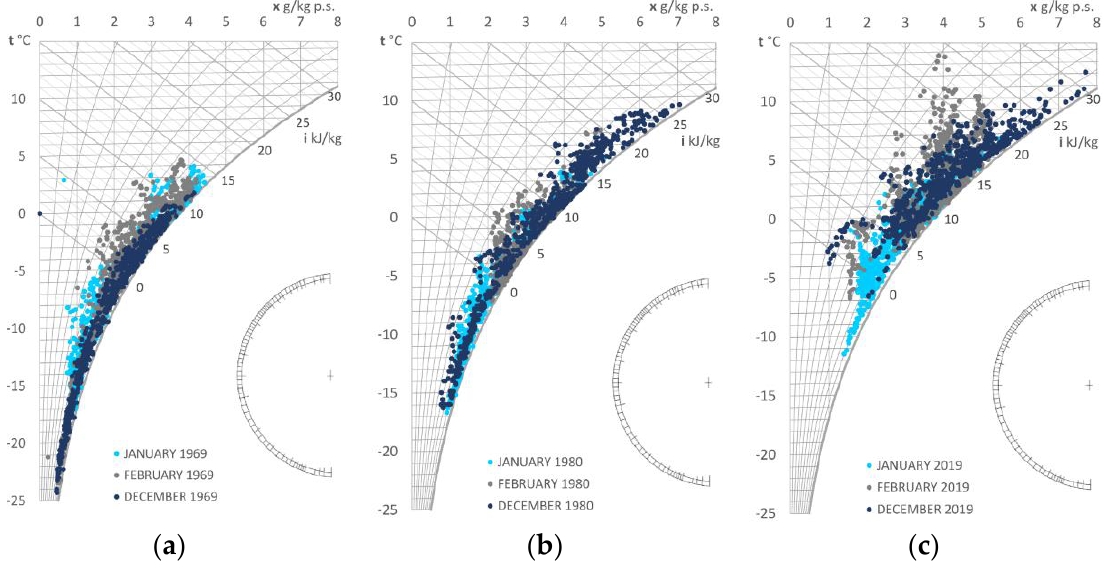
Figure 3. Hourly average external air parameters for the winter months (December, January, February) in the i-x Mollier diagram for years: ( a ) 1969, ( b ) 1980 and ( c ) 2019.